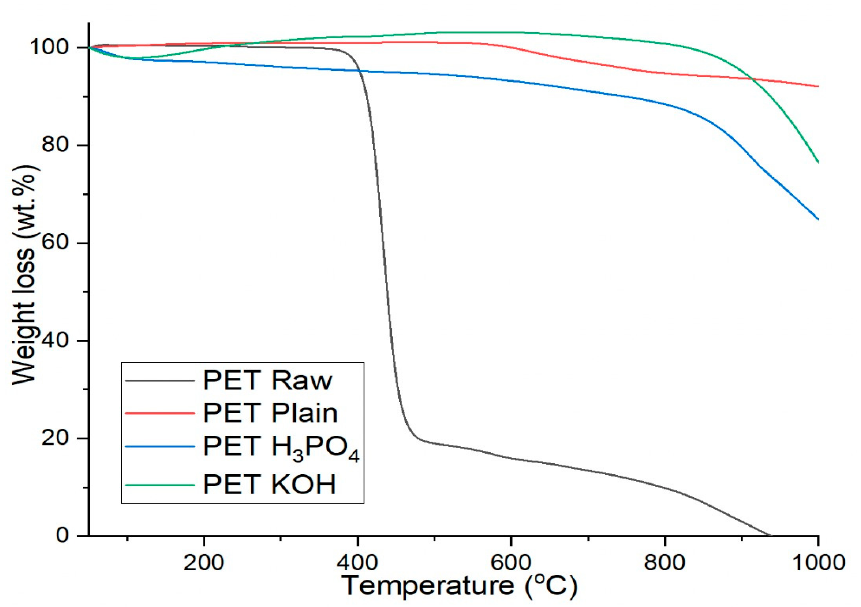
Figure 4. TGA curve of PET Raw, PET Plain, PET H 3 PO 4 and PET KOH.